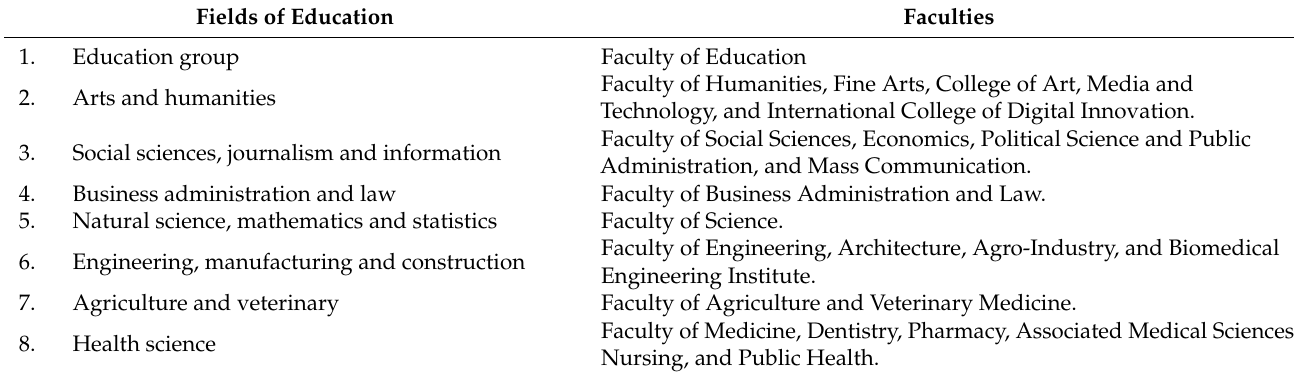
Table 1. The fields of Education and Training by International Standard Classification of Education (ISCED) 2013. Fields of